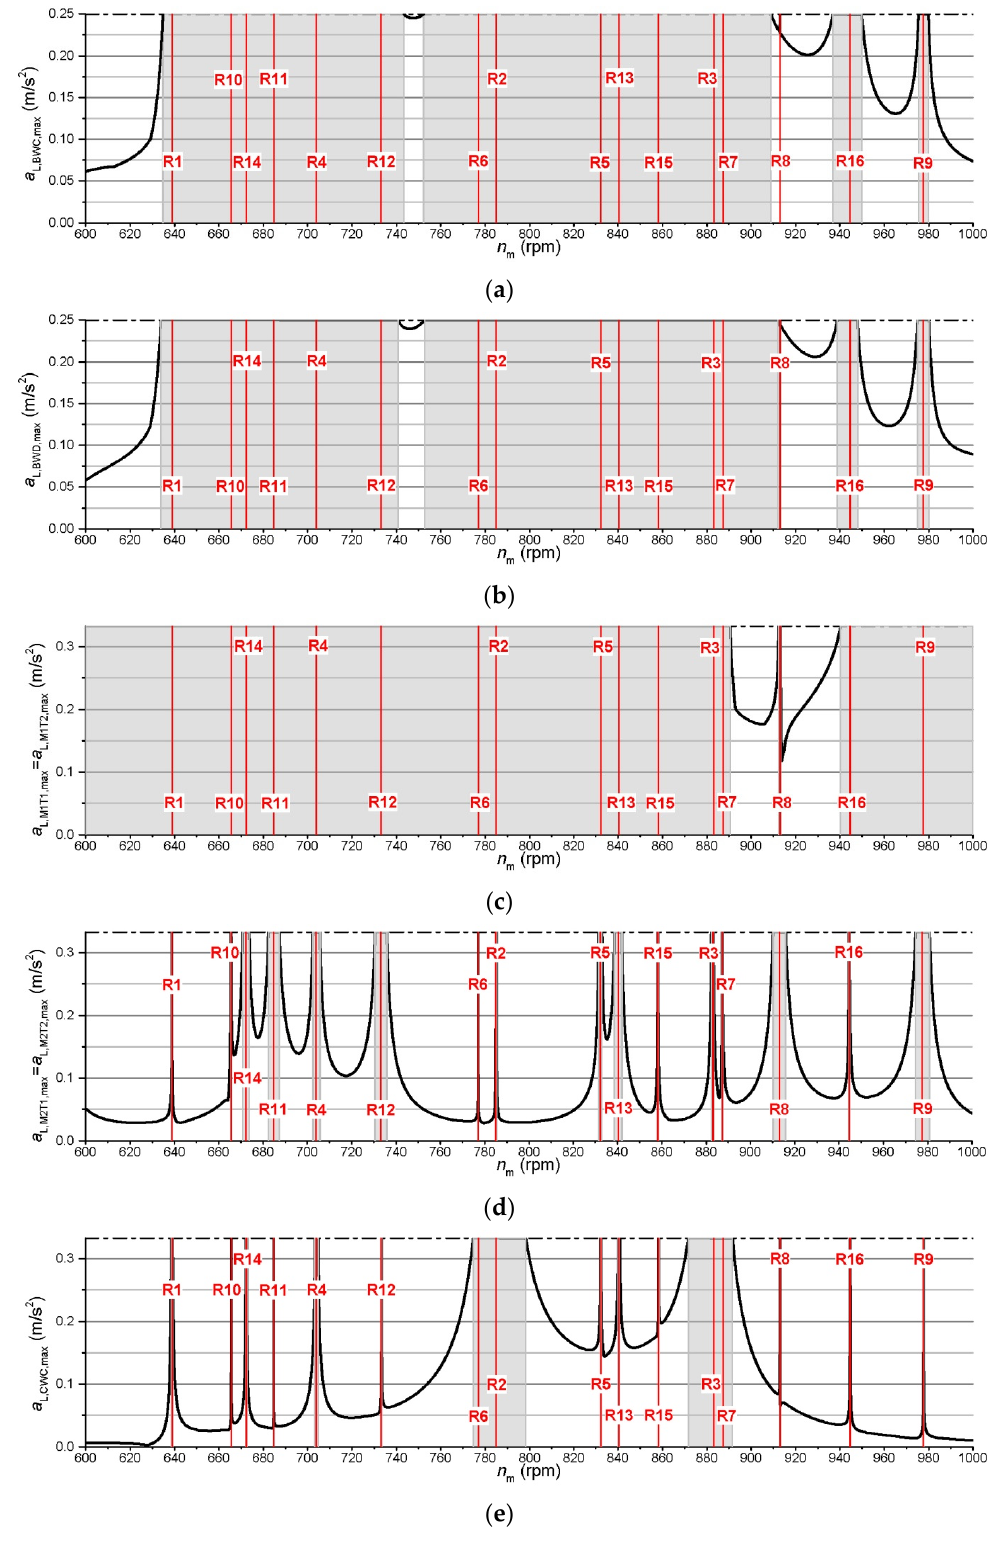
Figure 16. Total response to the excitation caused by the resistance to excavation—maximal lateral accelerations of the referent points of the slewing superstructure: ( a ) BWC; ( b ) BWD; ( c ) M1T1, M1T2; ( d ) M2T1, M2T2; ( e ) CWC (the excessive total lateral acceleration zones are grey-colored).